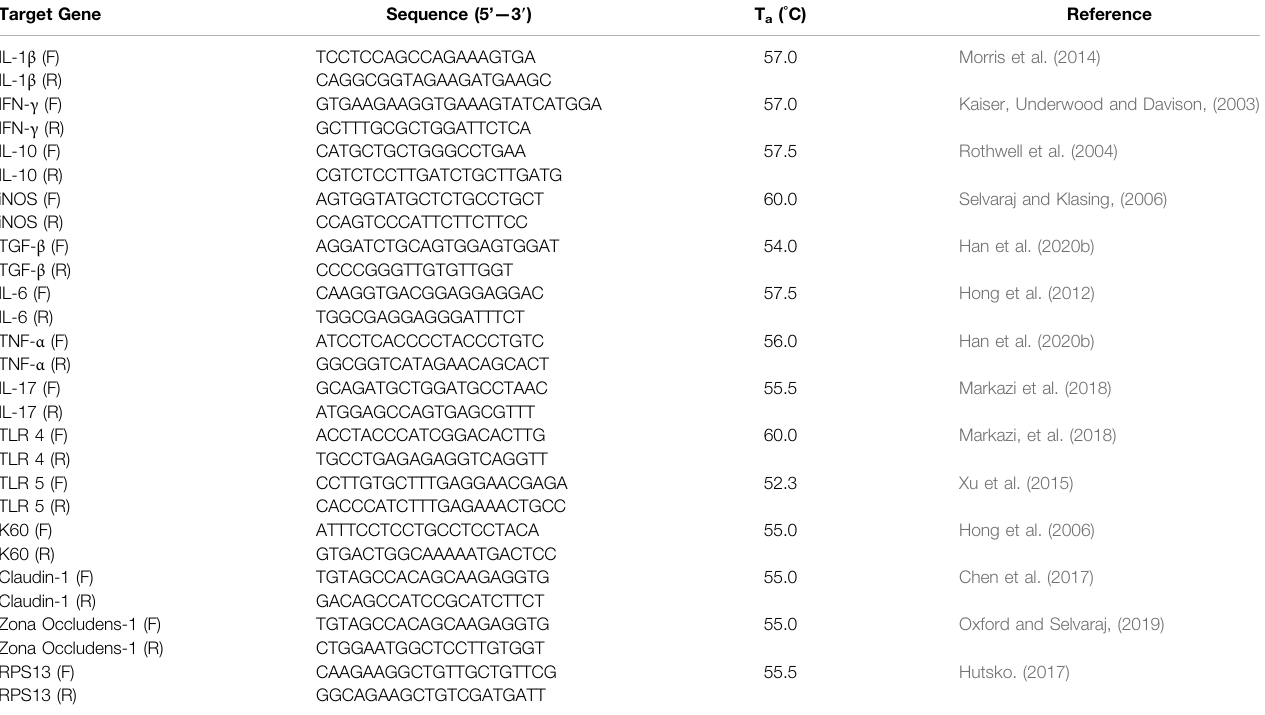
TABLE 2 | Primers and PCR conditions for RT-PCR.